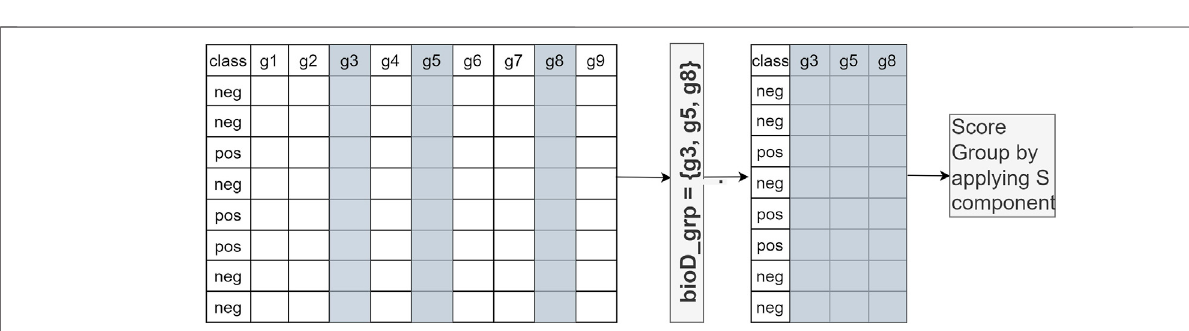
Frontiers in Genetics |